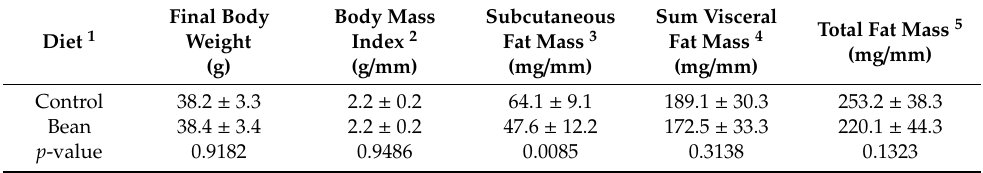
Table 4. E ff ect of white kidney bean on body weight and adiposity (Experiment